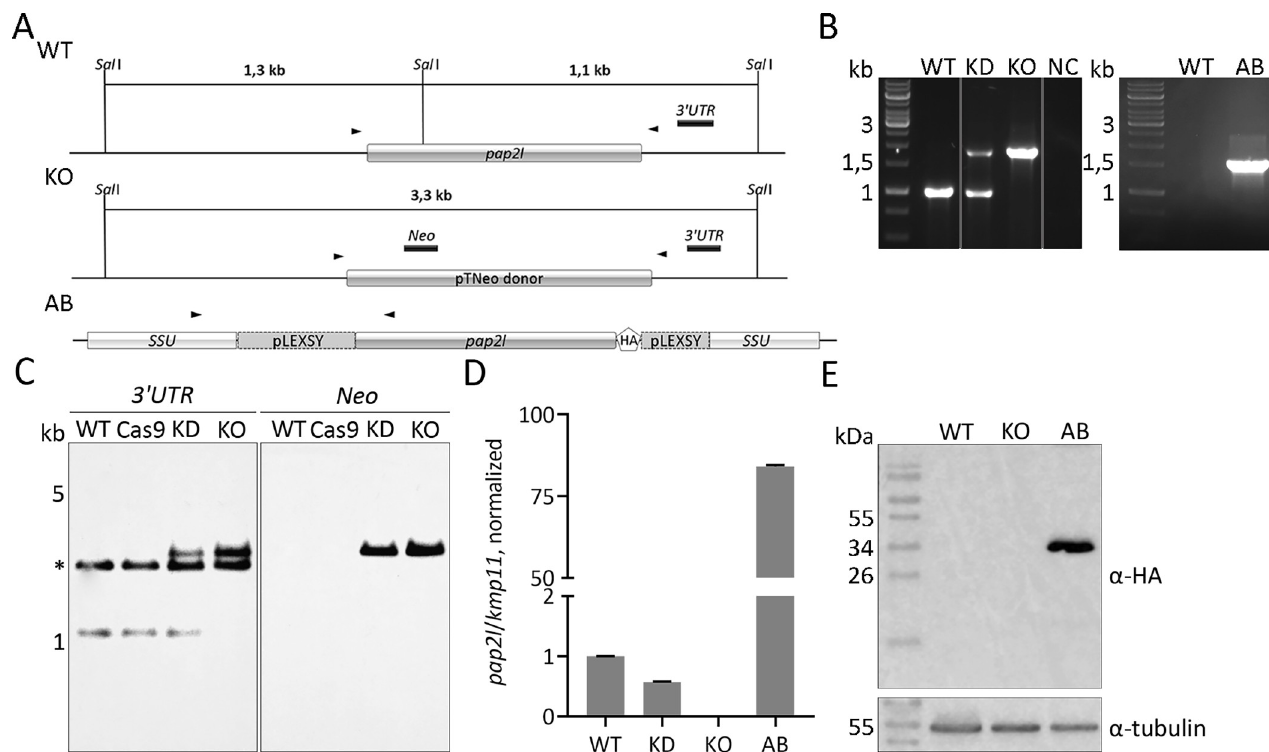
Fig 2. Genetic ablation of pap2l using CRISPR-Cas9 approach in L . guyanensis . (A) Schematic representation of the wild type (WT), recombined (KO), and reintroduced (AB) pap2l alleles. Expected sizes of DNA fragments after Sal I digestion, positions of the annealed probes for Southern blotting and primers for diagnostic PCR (arrowheads) are indicated. (B) Diagnostic PCR for the WT, KD and KO (left) and AB (right) pap2l alleles in L . guyanensis . NC, negative control. (C) Southern blotting analysis of the Sal I-digested total genomic DNA of the WT, Cas9/T7, KD, and KO L . guyanensis . Membranes were probed with 3 0 UTR and Neo probes. A non-specific band in anti- 3 0 UTR analysis is marked by the asterisk. (D) Quantitative RT-PCR analysis of pap2l expression in the WT, KD, KO, and AB L . guyanensis . Data were normalized to the expression of kmp11 and presented as means and standard deviations of three independent biological replicates. (E) Western blotting confirmation of the Lg PAP2L-HA expression in the AB line. Probing with anti-tubulin antibody served as a loading control.